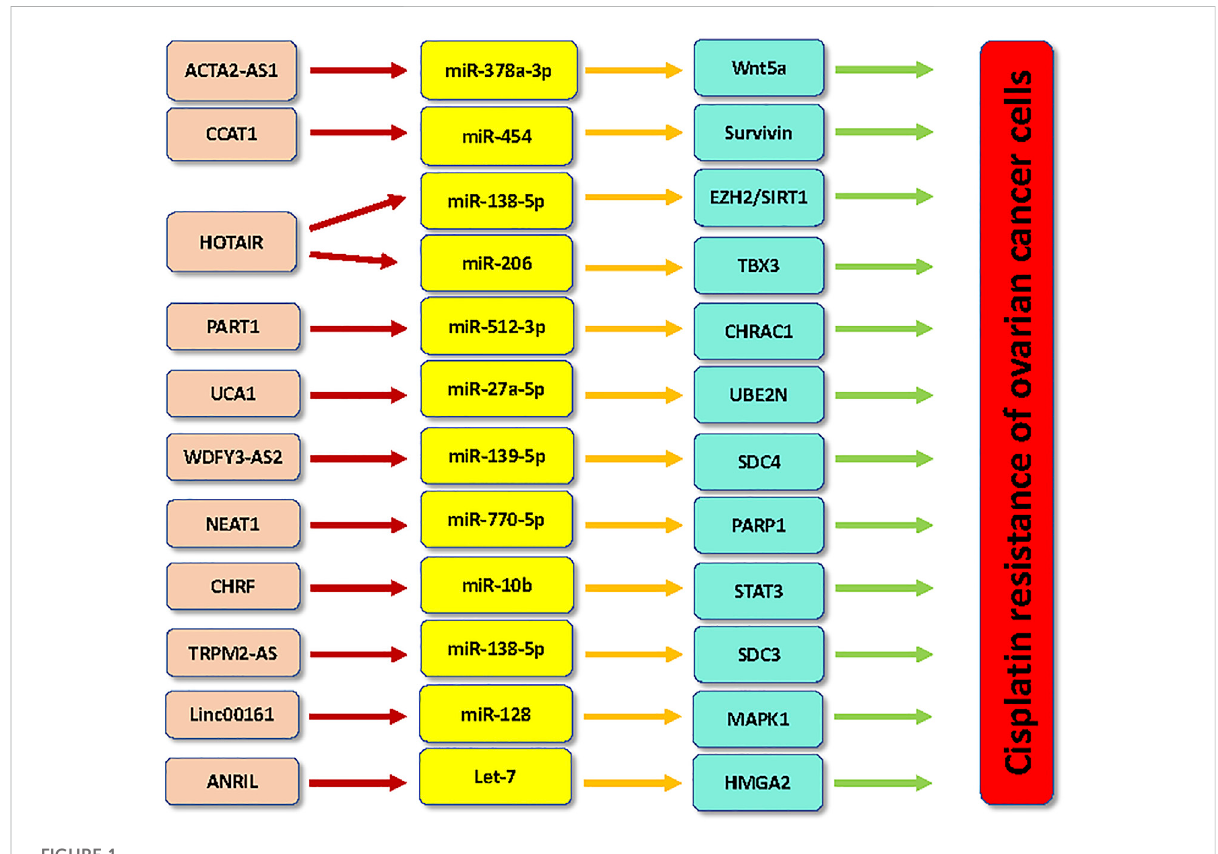
FIGURE 1 LncRNAs regulate the cisplatin resistance in ovarian